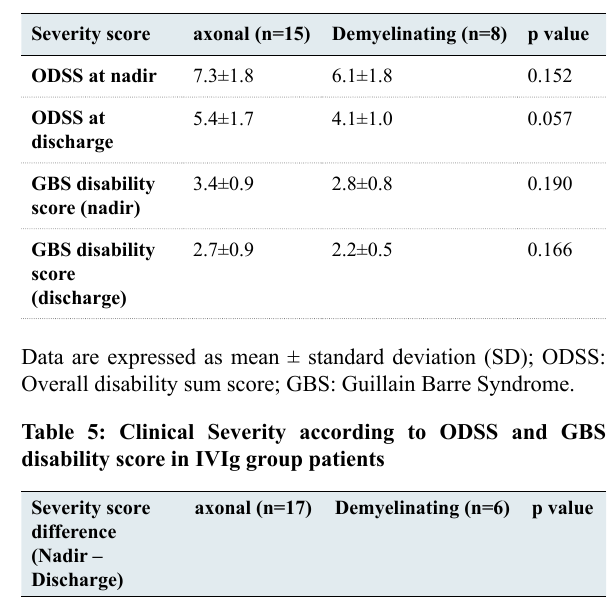
Table 4: Clinical Severity according to ODSS and GBS